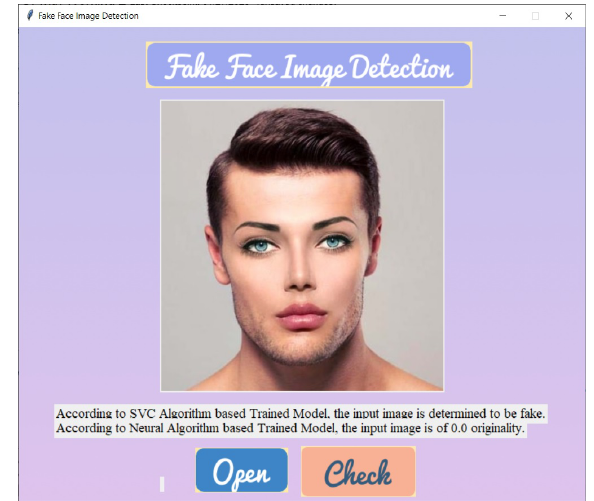
Figure 10. Result of a fake image